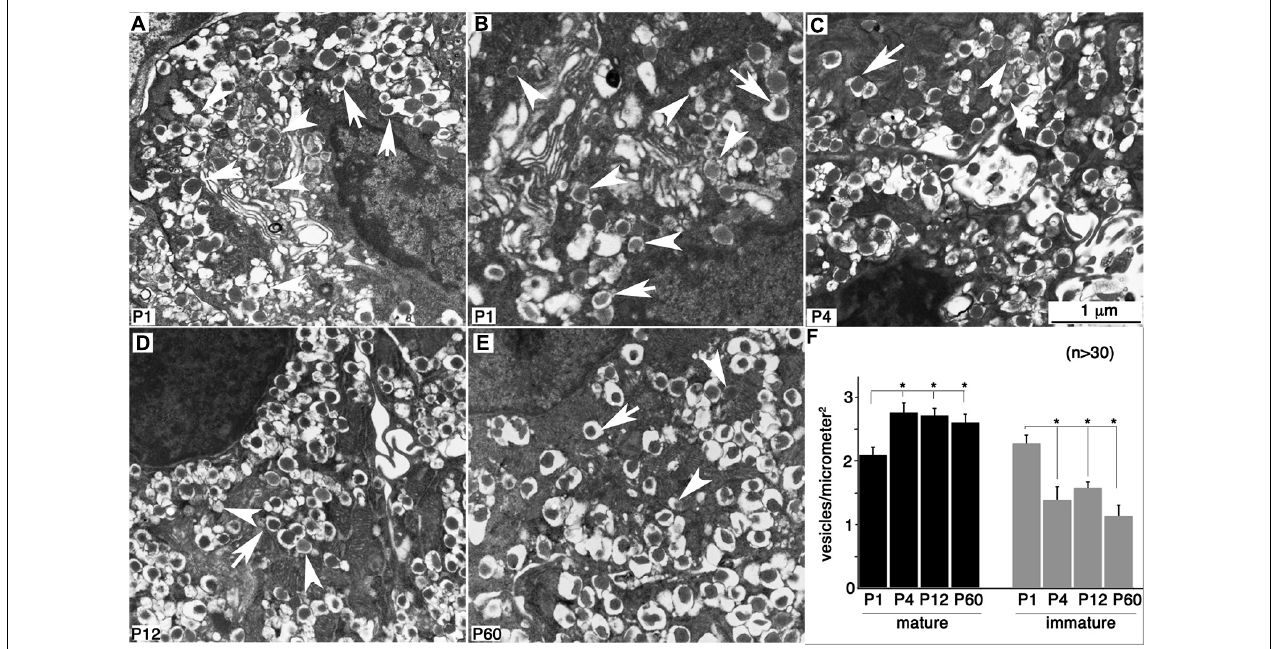
FIGURE 6 | Normal-looking vesicles are present in immature β cells. Hand-picked islets were fixed and examined with TEM. (A,B) Two P1 β cells showing different status of vesicular packaging. (C–E) Representative images of P4, P12, and P60 β cells. Arrows point to normal-looking “mature” vesicles. Arrowheads point to “immature” vesicles with less dense cores. (F) The levels of mature and immature vesicles in β cells are established by P4 based on quantitation with at least 26 microscopic views (1–3 β cells in each view) counted. Images used were from different blocks of at least four mice at each stage. * p < 0.05, two-sided Student t -test ( n >